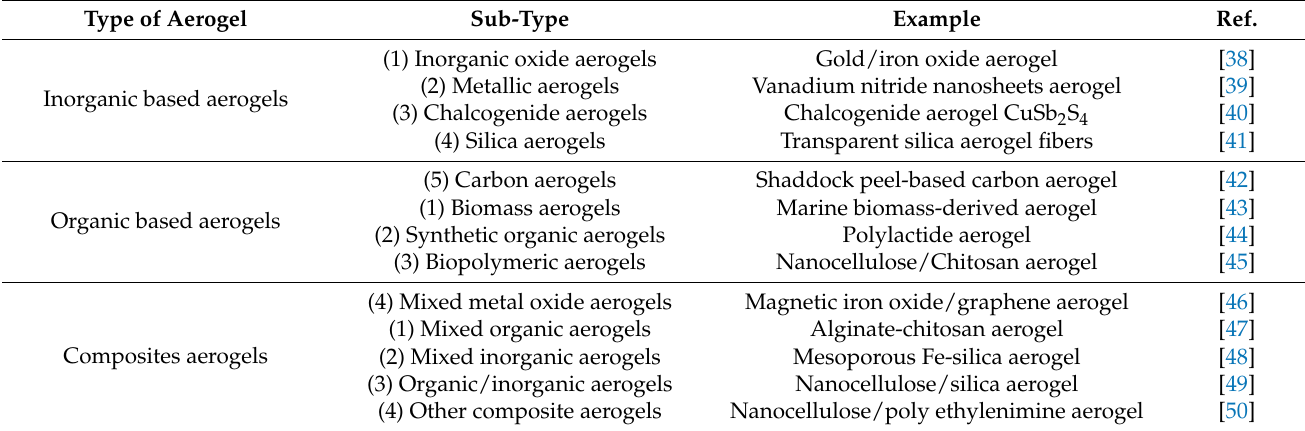
Table 1. Classification of aerogels based on the precursor material/s. Type of Aerogel Sub-Type Example